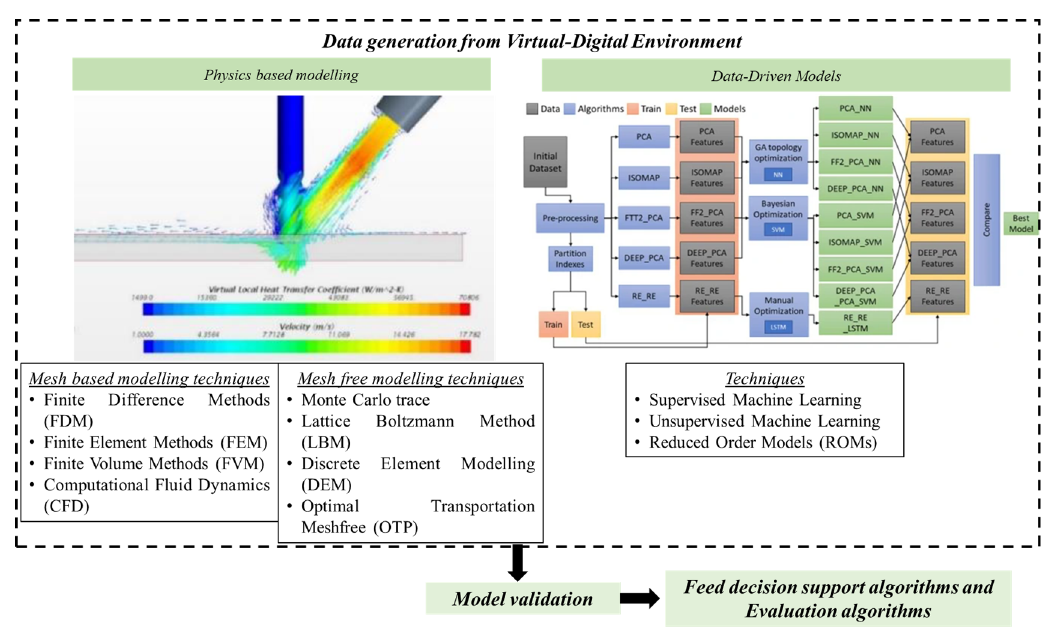
Figure 7. Data generation from virtual-digital environment and simulation models [39,75,76].